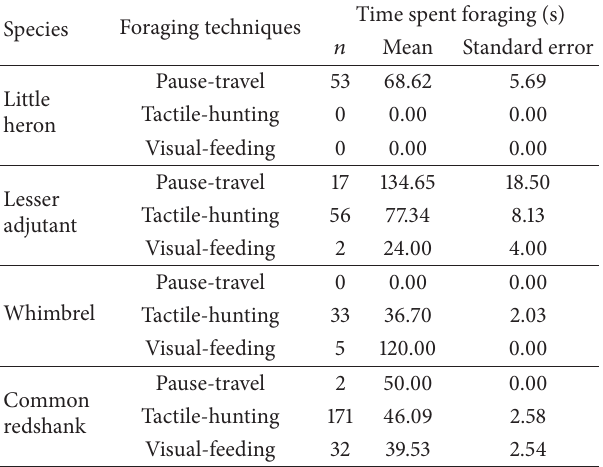
Table 5: Sample size ( 𝑛 ), mean and standard error of time spent foraging, and foraging techniques used by